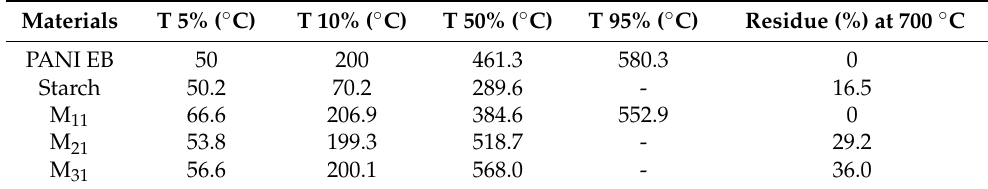
Table 6. Thermal characteristics of PANI, starch, and PANI/starch biocomposites (% weight loss at specific temperatures).